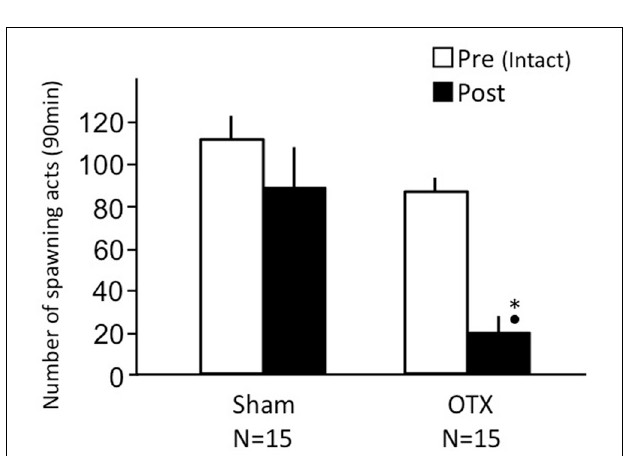
FIGURE 2 | Effects of olfactory tract section on male sexual behavior in male goldfish. Pre, Pre-treatment (open column). Post, post-treatment (solid column). Each column represents the mean and s.e.m. Difference compared to pre-treatment (asterisk), compared to sham-operated fish (solid circle). Level of significance, p < 0 .